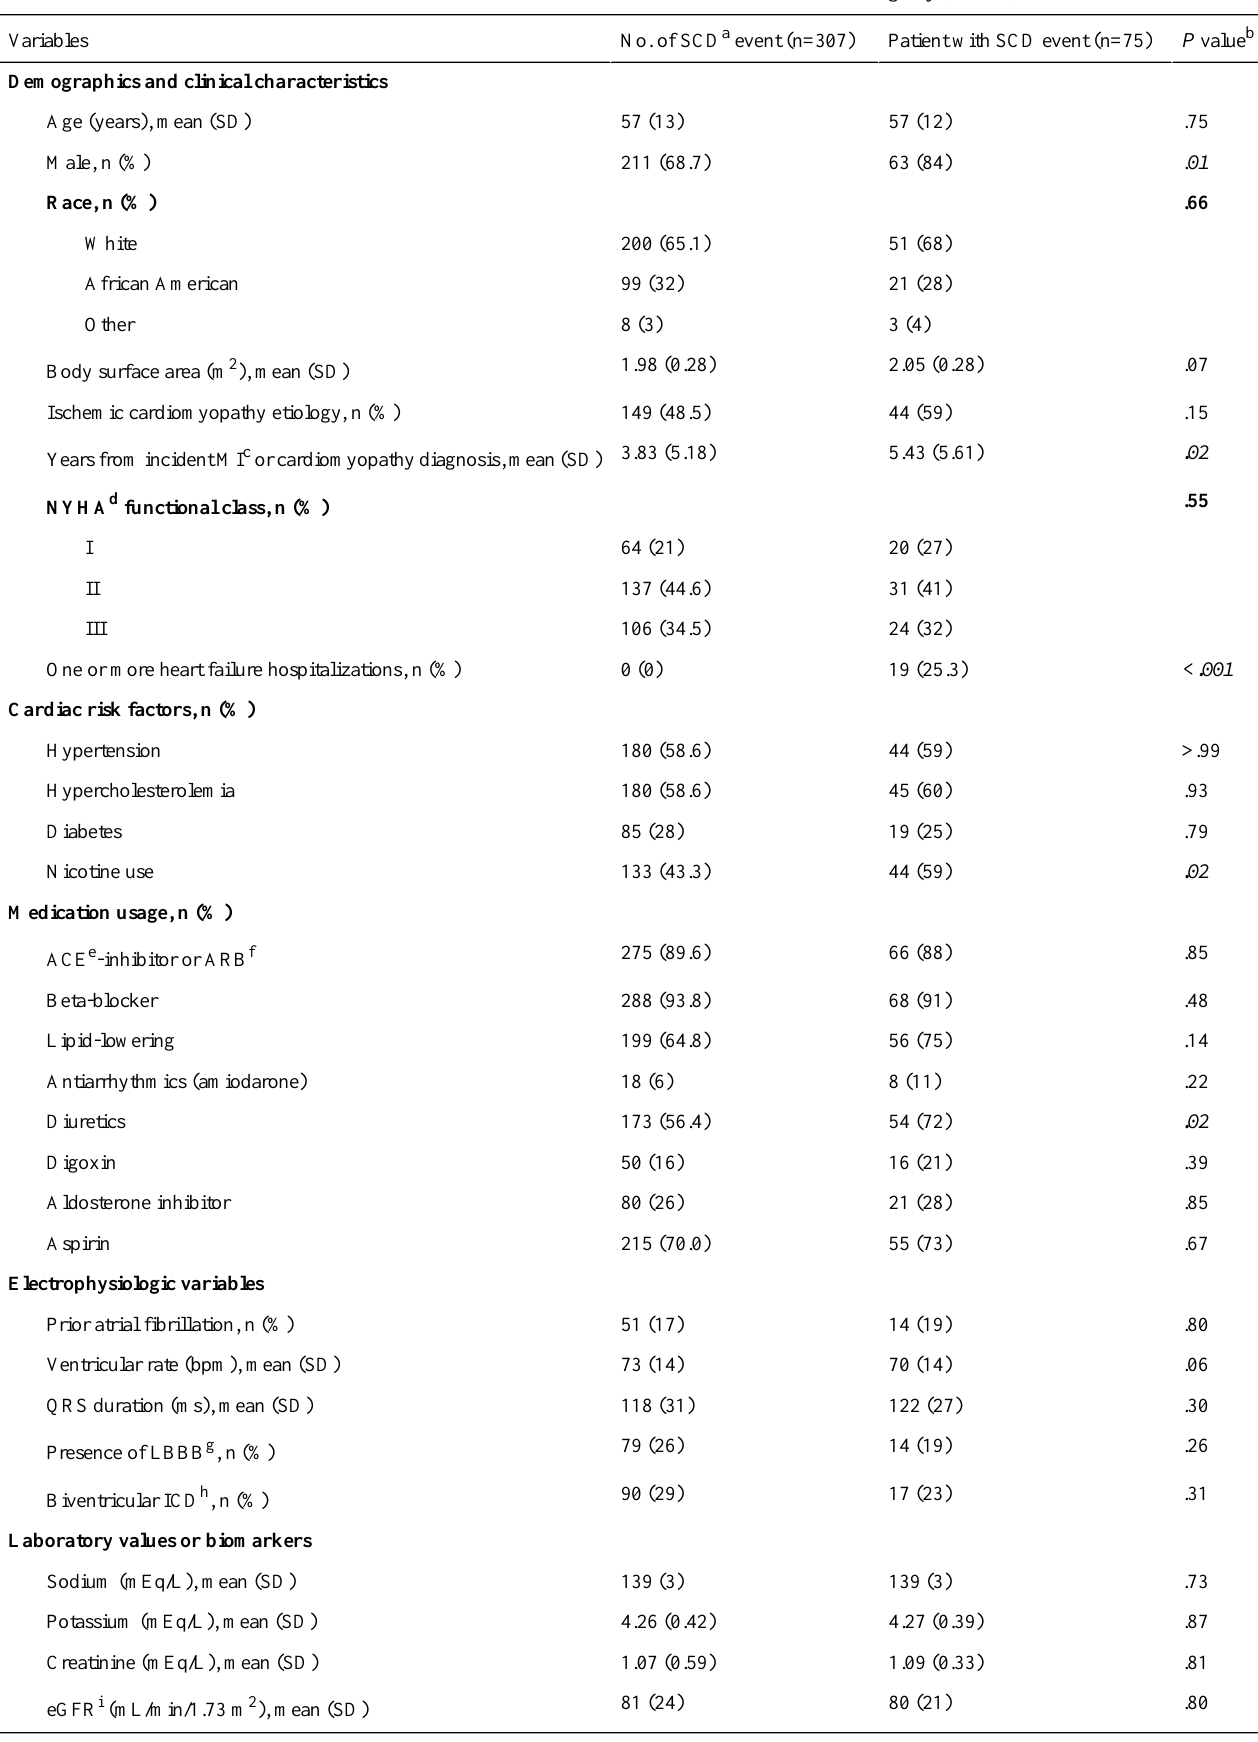
Table 1. Patient characteristics in the Left Ventricular Structural Predictors of Sudden Cardiac Death Registry